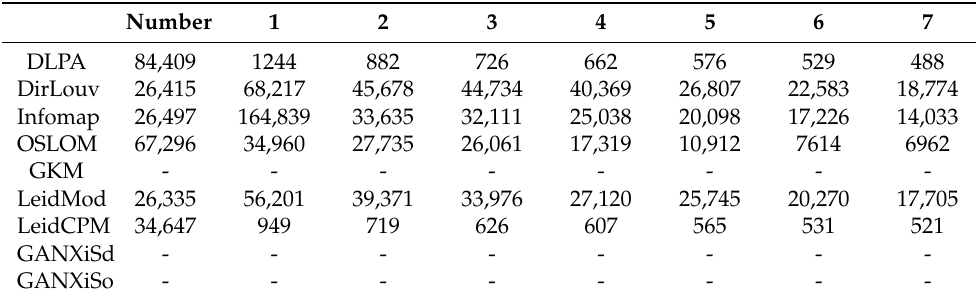
Table 8. The number of communities obtained on the Charlie Hebdo dataset and the value of the seven largest of them for each